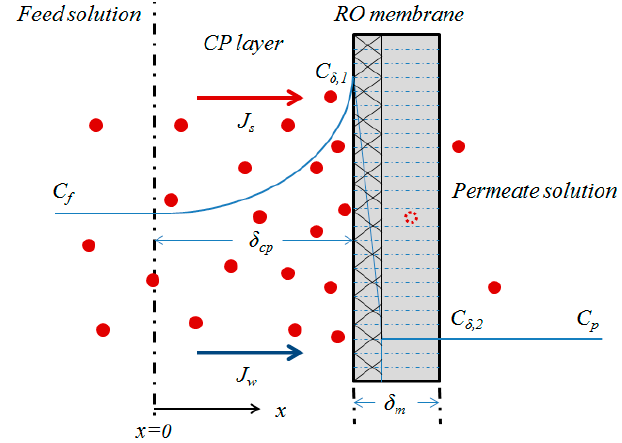
Figure 1. Schematic diagram of mass transfer in the reverse osmosis (RO) membrane separation process. CP: